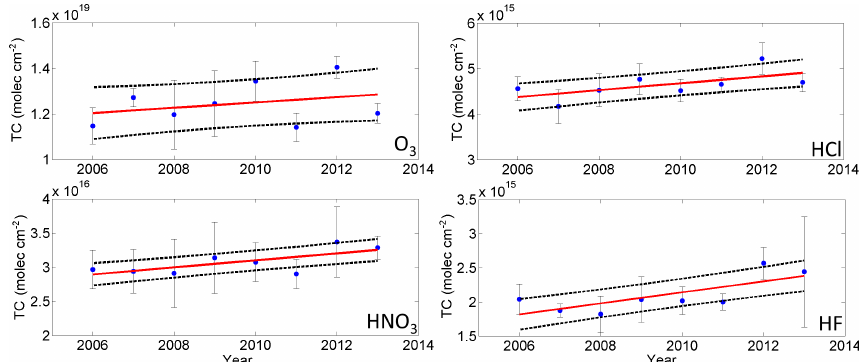
Figure 6. Springtime campaign averages (and 1 σ standard deviation) between 2006 and 2013 obtained from the PARIS-IR total column retrievals for all stratospheric species for measurements that were taken outside the polar vortex (sPV < 1 . 2 × 10 − 4 s − 1 at 20km along the line of sight). The colour and symbol scheme is the same as in Fig.